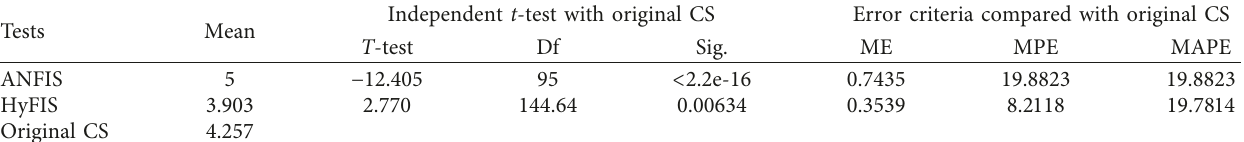
Table 6: ANFIS and HyFIS for predicting 10% of